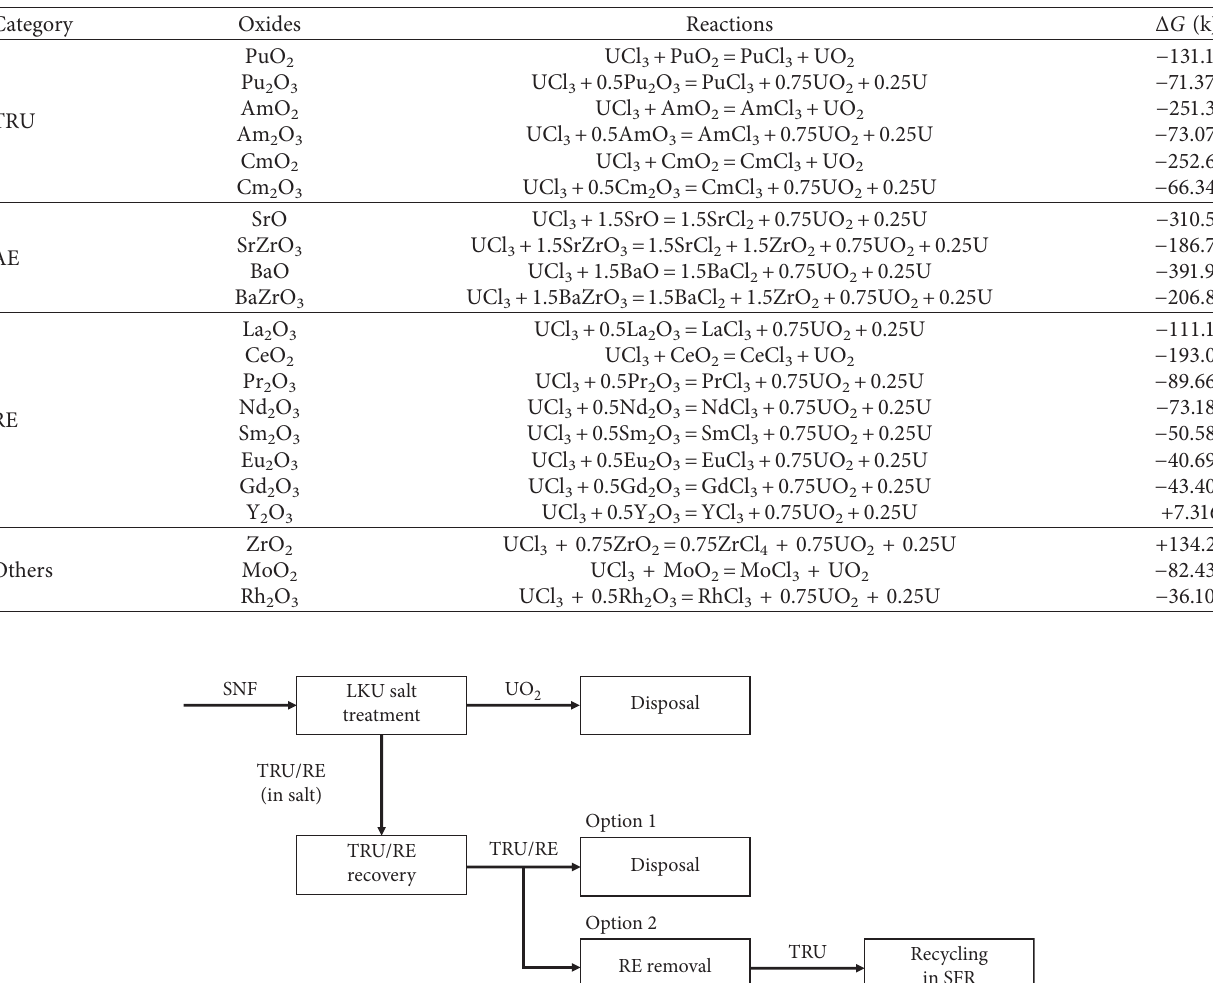
° C. 3 and oxide components of SNFs at 500